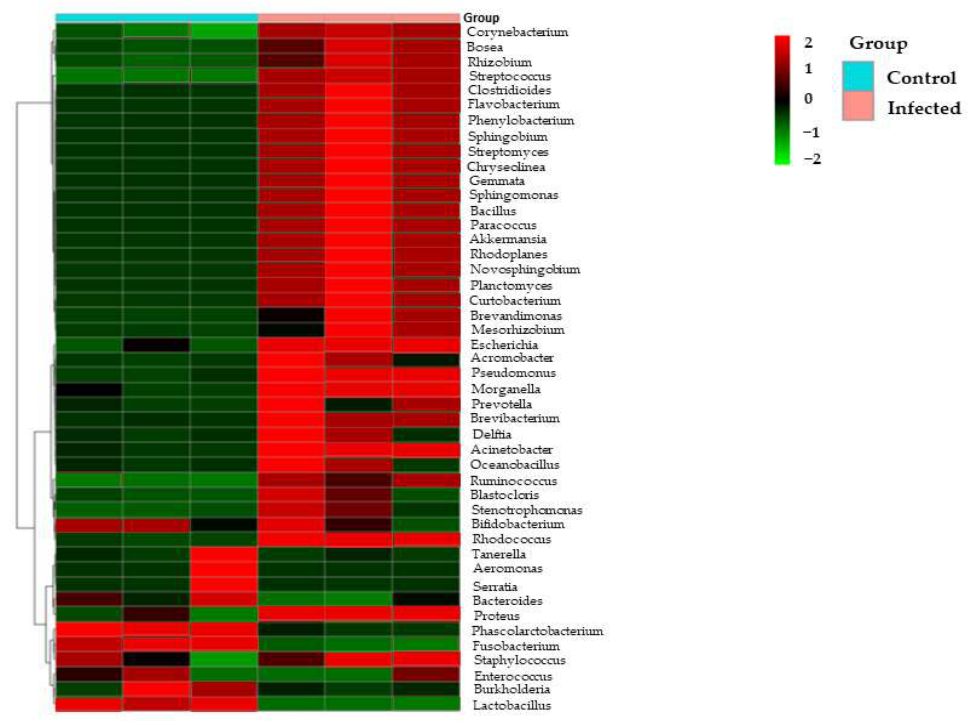
Figure 3. Heatmap showing the normalized relative abundances which were significantly changed in Control vs. Infected groups.